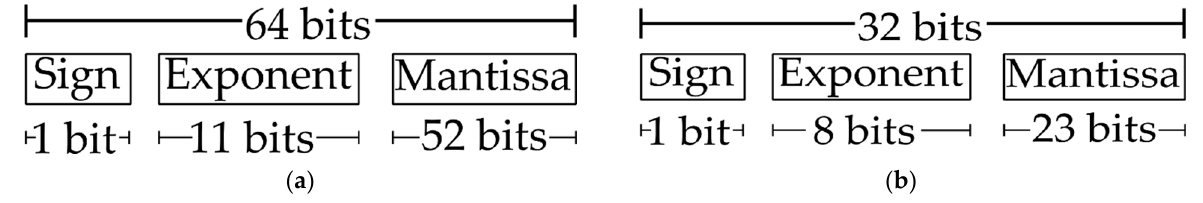
Figure 5. ( a ) IEEE 754 Single-precision 32-bit format. ( b ) IEEE 754 Double-precision 64-bit format.